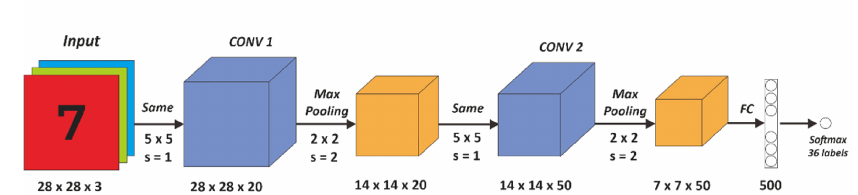
Fig. 5 Modified LeNet-5 architecture [24]